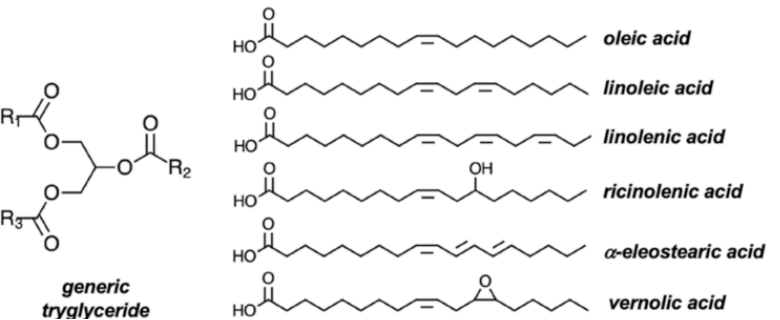
Figure 4. Molecular representation of a generic structure of natural triglycerides, with R 1 , R 2 , and R 3 representing fatty acid chains; the most common naturally available fatty acids are depicted on the